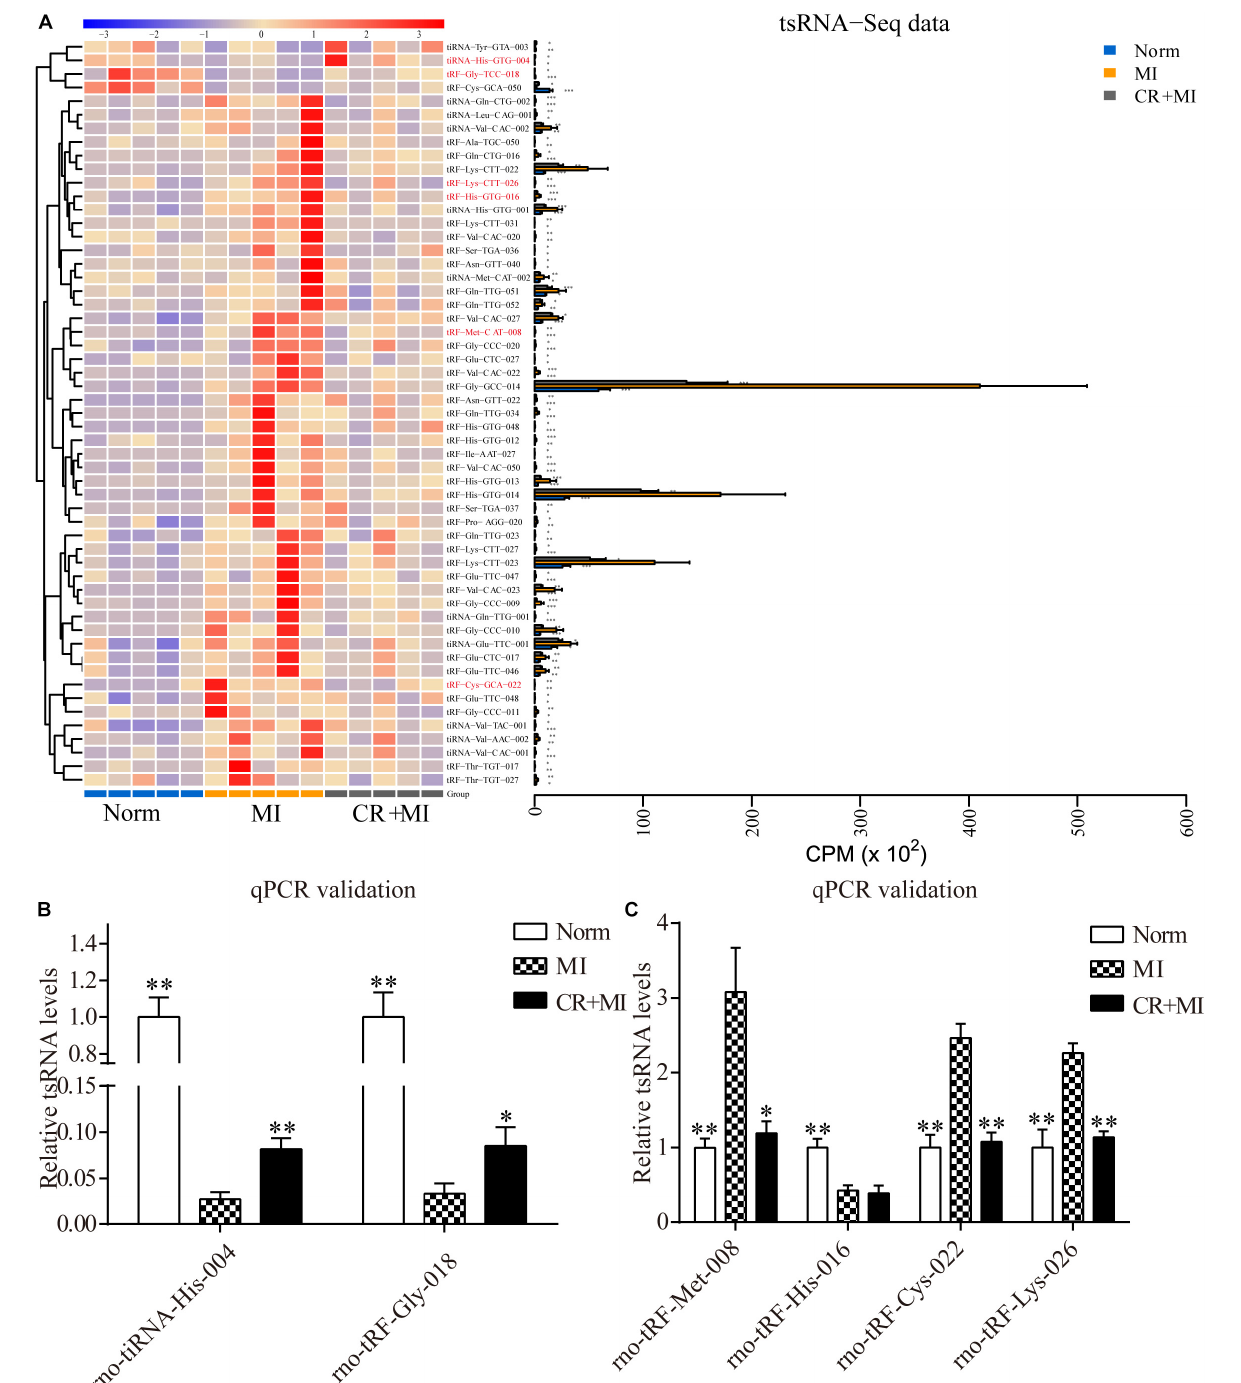
Frontiers in Cell and Developmental Biology |